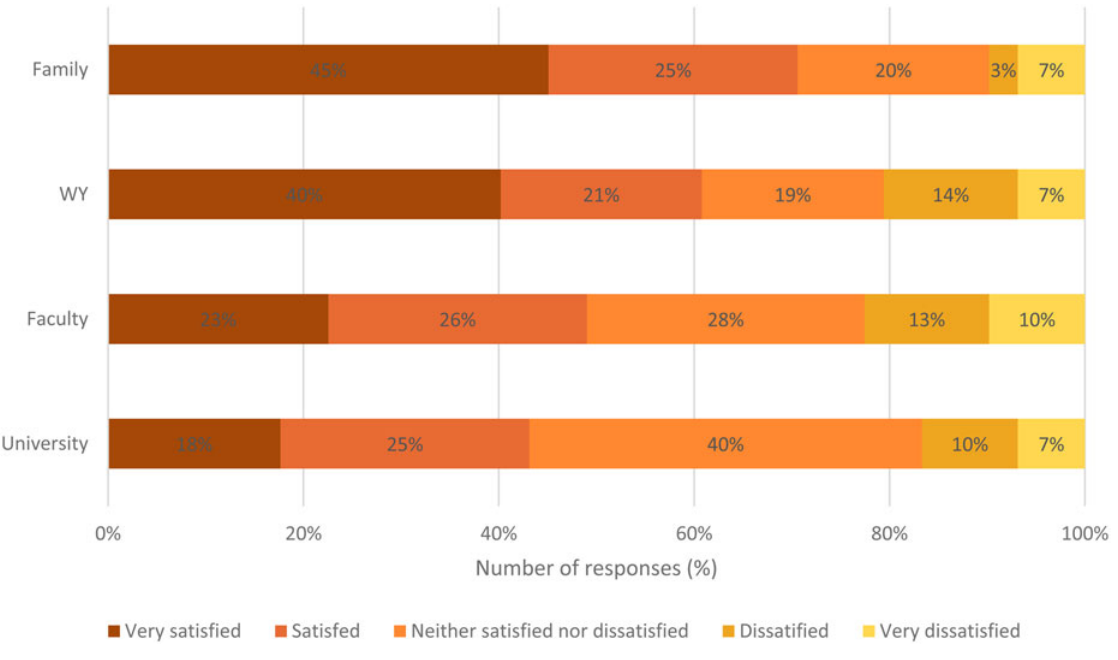
Fig. 1. Descriptive statistics of students ’ satisfaction with varying modes of support. Note : Wirltu Yarlu (WY).